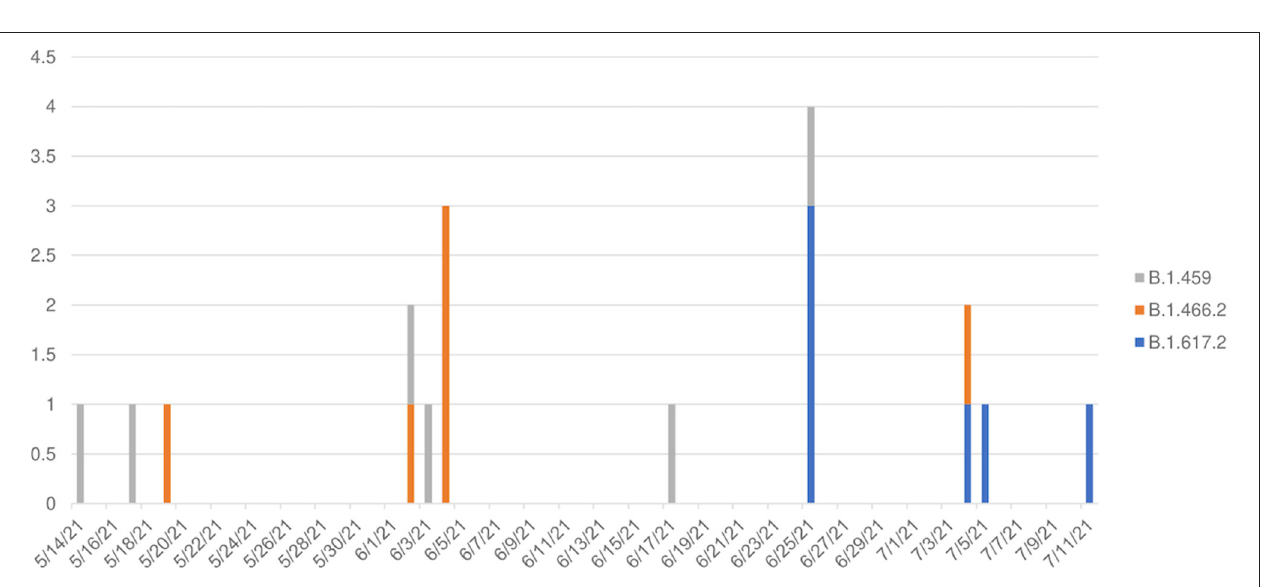
FIGURE 3 | Temporal pattern of variants among 18 children with COVID-19 in North Sumatra, Indonesia. ( X axis: date of detection (d/m/y); Y axis: number of